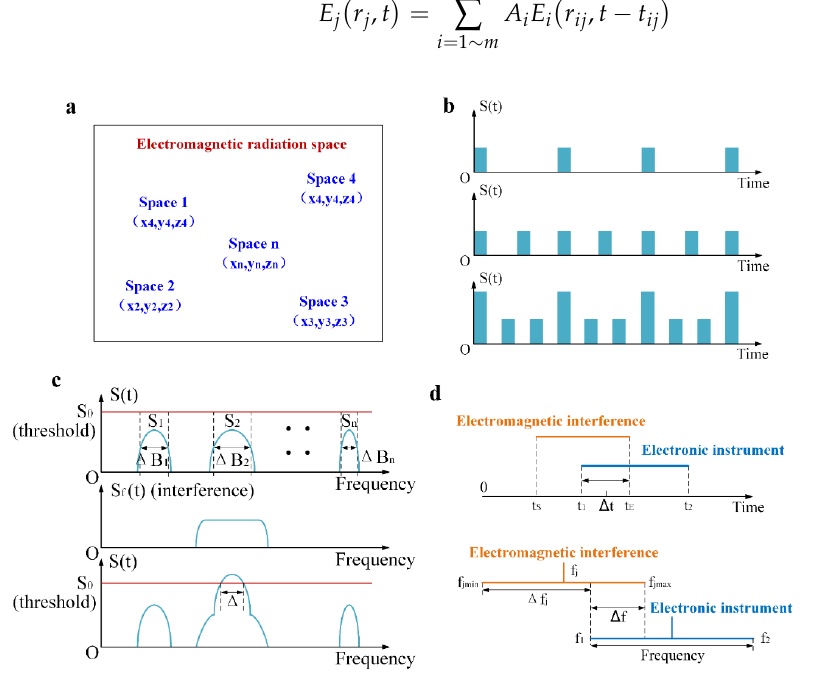
Figure 4. Analysis and modelling of electromagnetic radiation. ( a ) Distribution of electromagnetic radiation sources; ( b ) Schematic diagram of time-domain characteristics; ( c ) Schematic diagram of frequency-domain characteristics; ( d ) Schematic diagram of electronic equipment affected by electromagnetic interference.